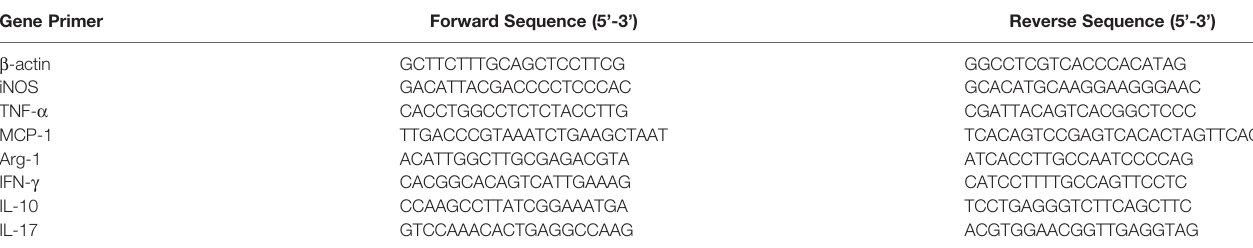
TABLE 2 | The primer sequences used in quantitative real-time PCR. Gene Primer Forward Sequence (5 ’ -3 ’ ) Reverse Sequence (5 ’ -3 ’